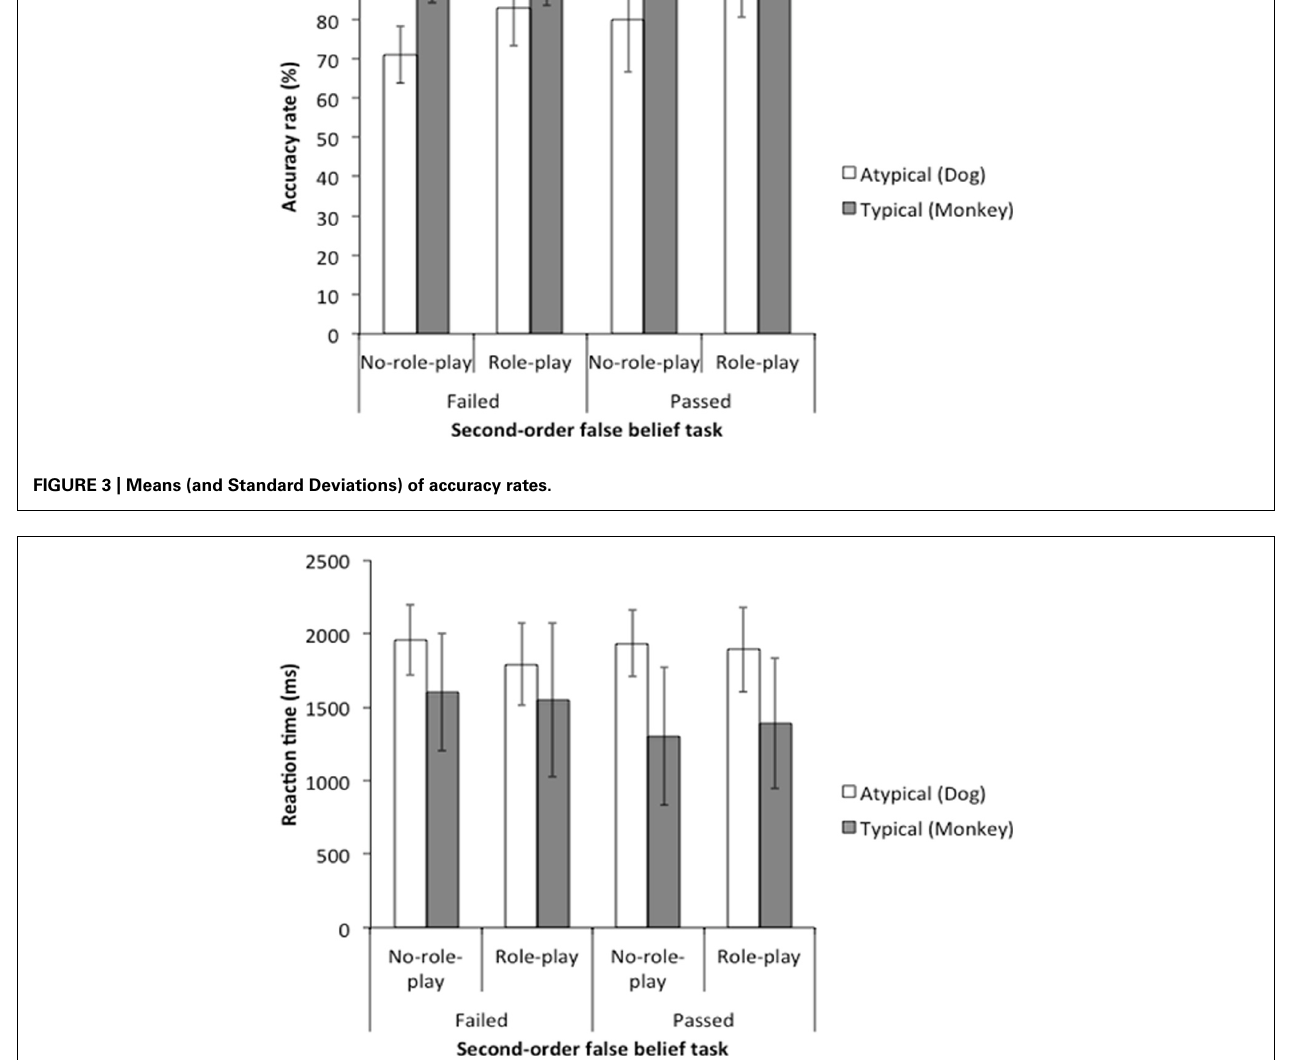
FIGURE 4 | Means (and Standard Deviations) of reaction